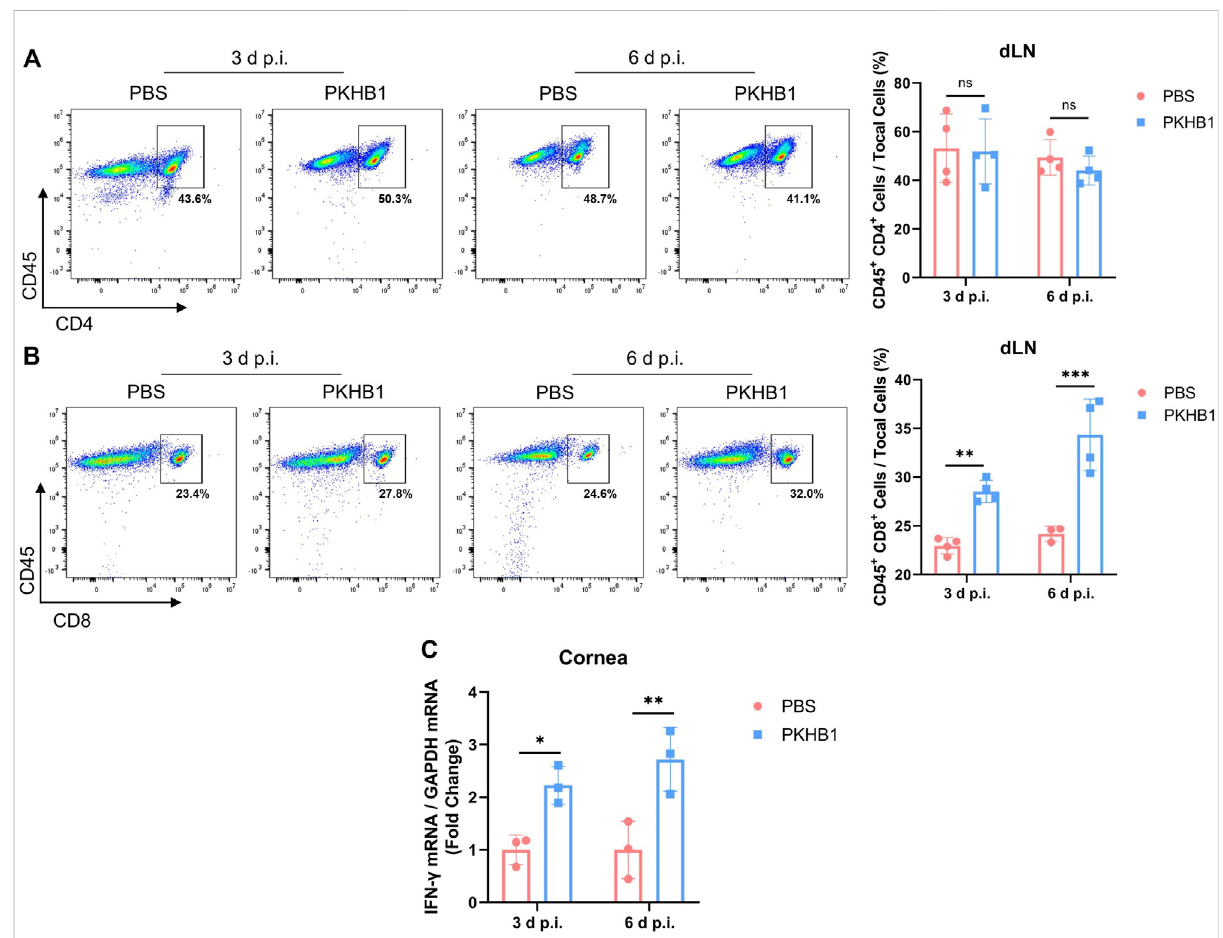
FIGURE 5 Subconjunctival injection of PKHB1 peptide increased the number of CD8 + T cells in the dLNs. Representative fl ow cytometry plots and bar charts showing the frequency of CD4 + T cells (A) and CD8 + T cells (B) in the dLNs of PKHB1 peptide or PBS topically treated HSK mice at 3 d p.i. and 6 d p.i. ( n = 4). There was no change in the number of CD4 + T cells but a signi fi cant increase in the number of CD8 + T cells after PKHB1 peptide administrations. (C) qRT-PCR detection of changes intheexpression levels ofIFN- γ inthemicecorneas ( n =3).The increasedexpressiononce again demonstrated that the PKHB1 peptide activated the immune response, leading to an increase in the ability of the cornea to fi ght viruses. Data were presented as mean ± SD of three independent experiments. (* p < 0.05, ** p < 0.01, *** p <